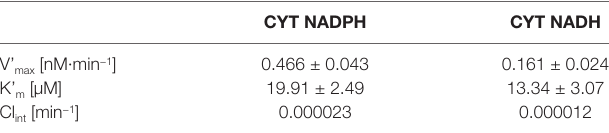
TABLE 2 | Kinetic parameters obtained for (+)-FLUR formation in the pooled human liver cytosol of both sexes with NADPH or NADH